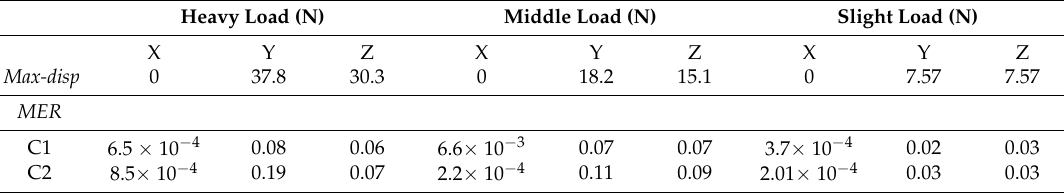
Table 3. Comparison of reconstruction accuracy under two schemes